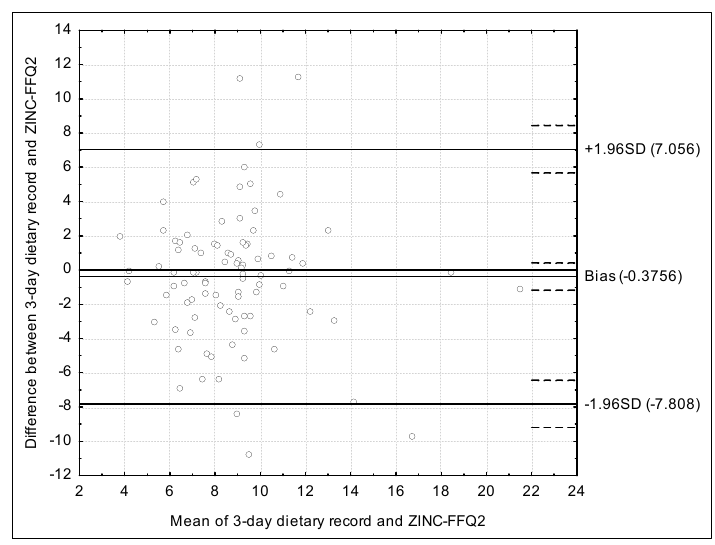
Figure 3. The assessment of the validity of the ZINC-FFQ conducted using the Bland–Altman plot for the ZINC-FFQ2 (Bland–Altman index of 6.7%). ZINC-FFQ2 = second food frequency questionnaire.